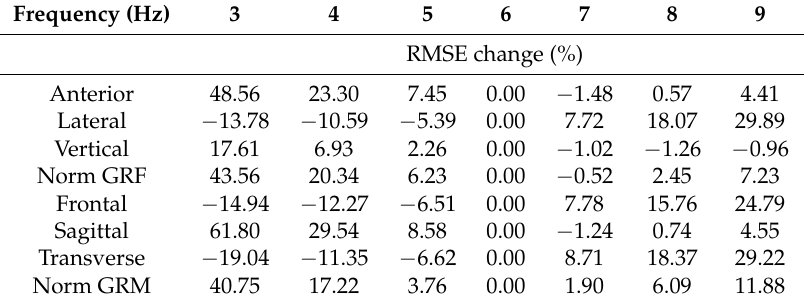
Table 10. Percentage change in the root mean square error (RMSE) of the three components and norms of the ground reaction force and moment, versus selected cut-off frequency for the second-order, zero-phase Butterworth low-pass filter. Negative values indicate improvement in the accuracy (decreased RMSE). The selected cut-off frequency (6 Hz) was used as a baseline for the